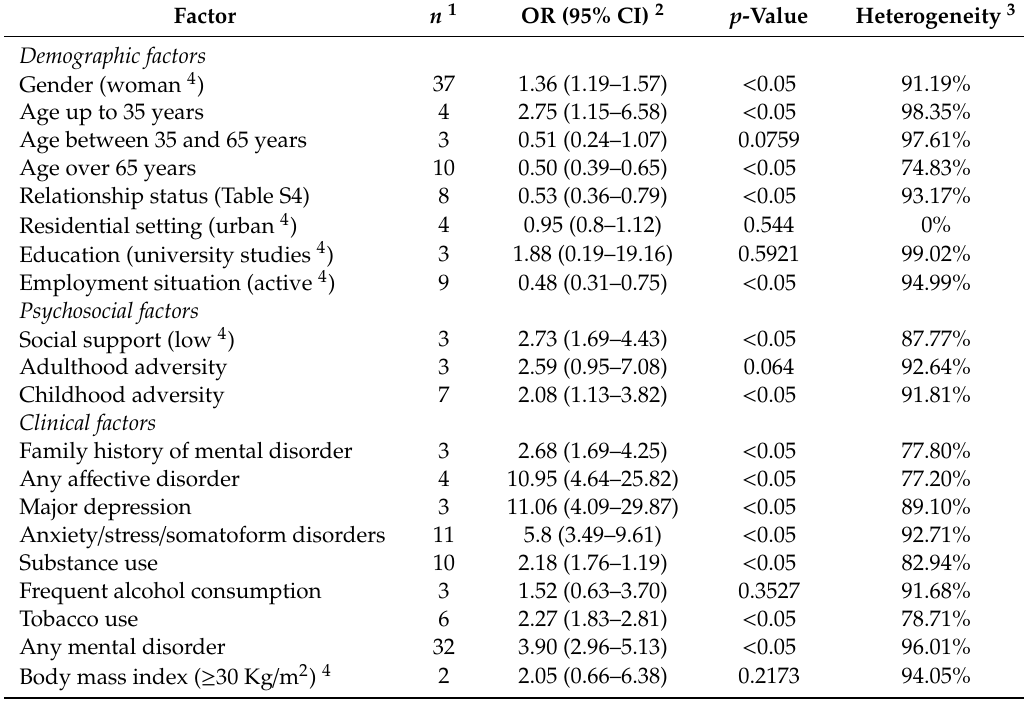
Table 3. Calculated odds ratio for suicidal ideation considering all time